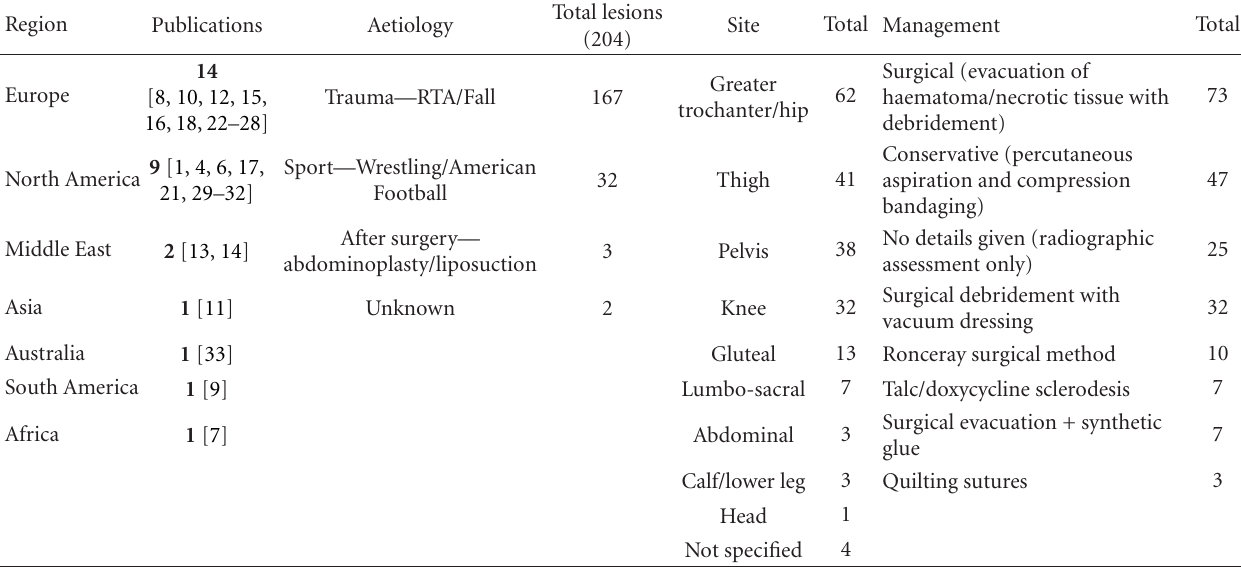
Table 1: Summary of literature on Morel-Lavall´ee